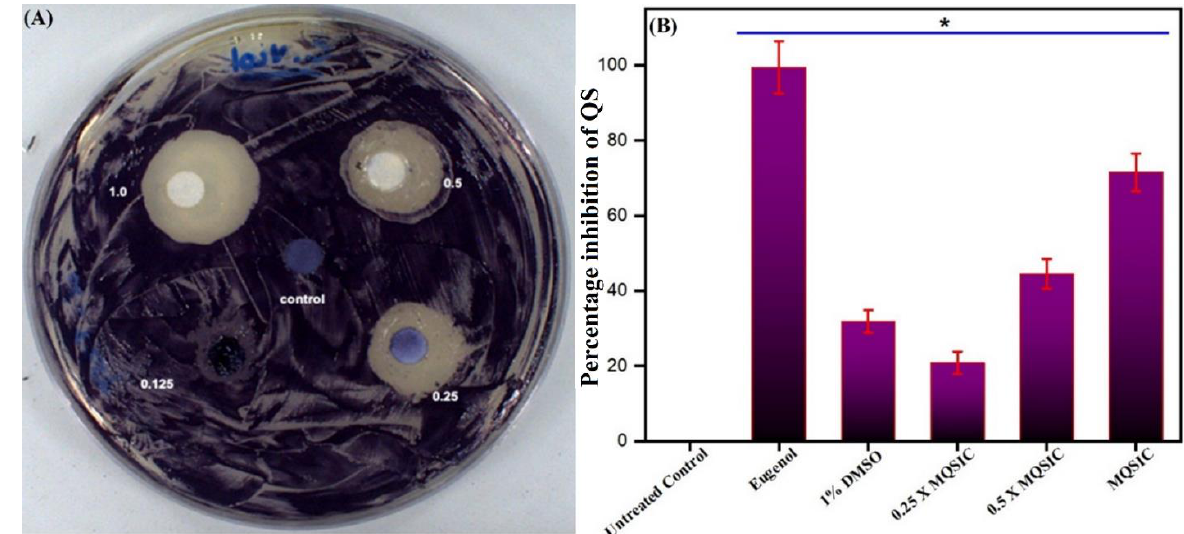
Figure 9. ( A ). Disc diffusion assay. The plate represents the antiquorum-sensing property of ZnO NPs at MQSIC and sub-MQSIC values. ( B ). Quantitative inhibition of violacein production by ZnO NPs. C. violaceum cells were treated with MQSIC and sub-MQSIC values of the ZnO NPs. The bar indicates healthy cells with no inhibition in violacein production, while eugenol and 1% DMSO represent positive and negative controls, respectively. Data represents means ± SD of three different values; * p ≤ 0.01.